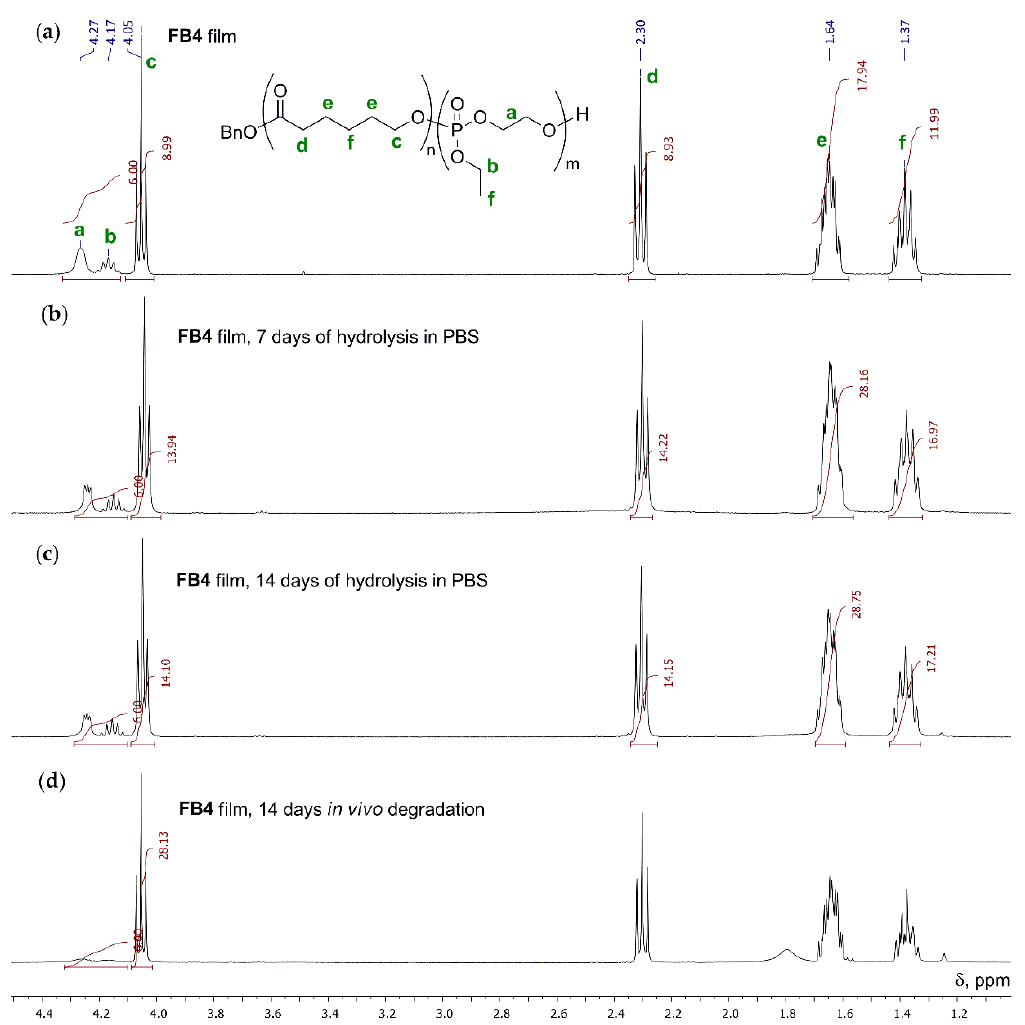
Figure 4. Hydrolytic degradation of FB4 film ( a ) in vitro ( b , c ) and in vivo ( d ).